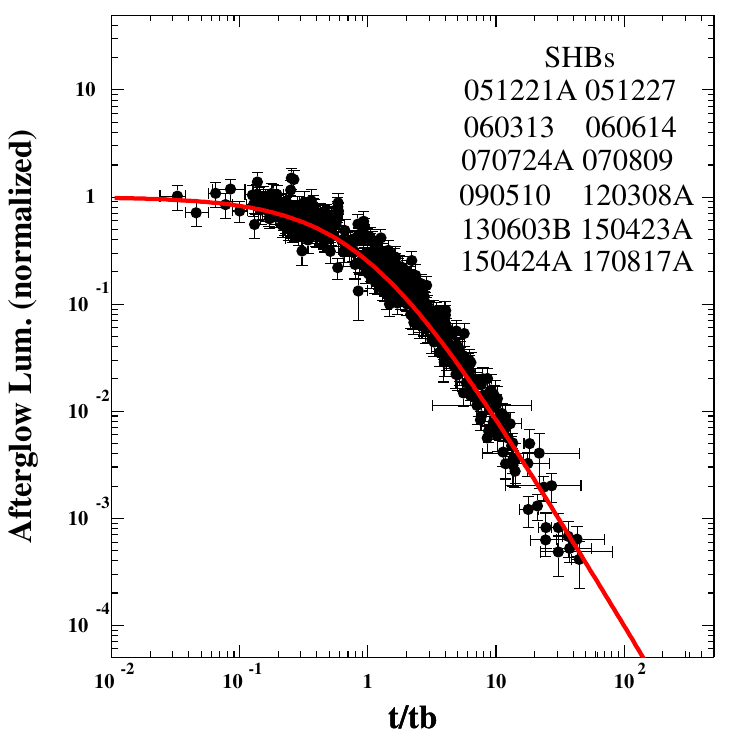
Figure 21. Comparison between the normalized light curve of the X-ray AG of 11 SHBs with a well sampled AG measured with Swift’s XRT [95,96] during the first couple of days after burst and the predicted universal behavior of Equation (19). The bolometric light curve of SHB170817A [118] is